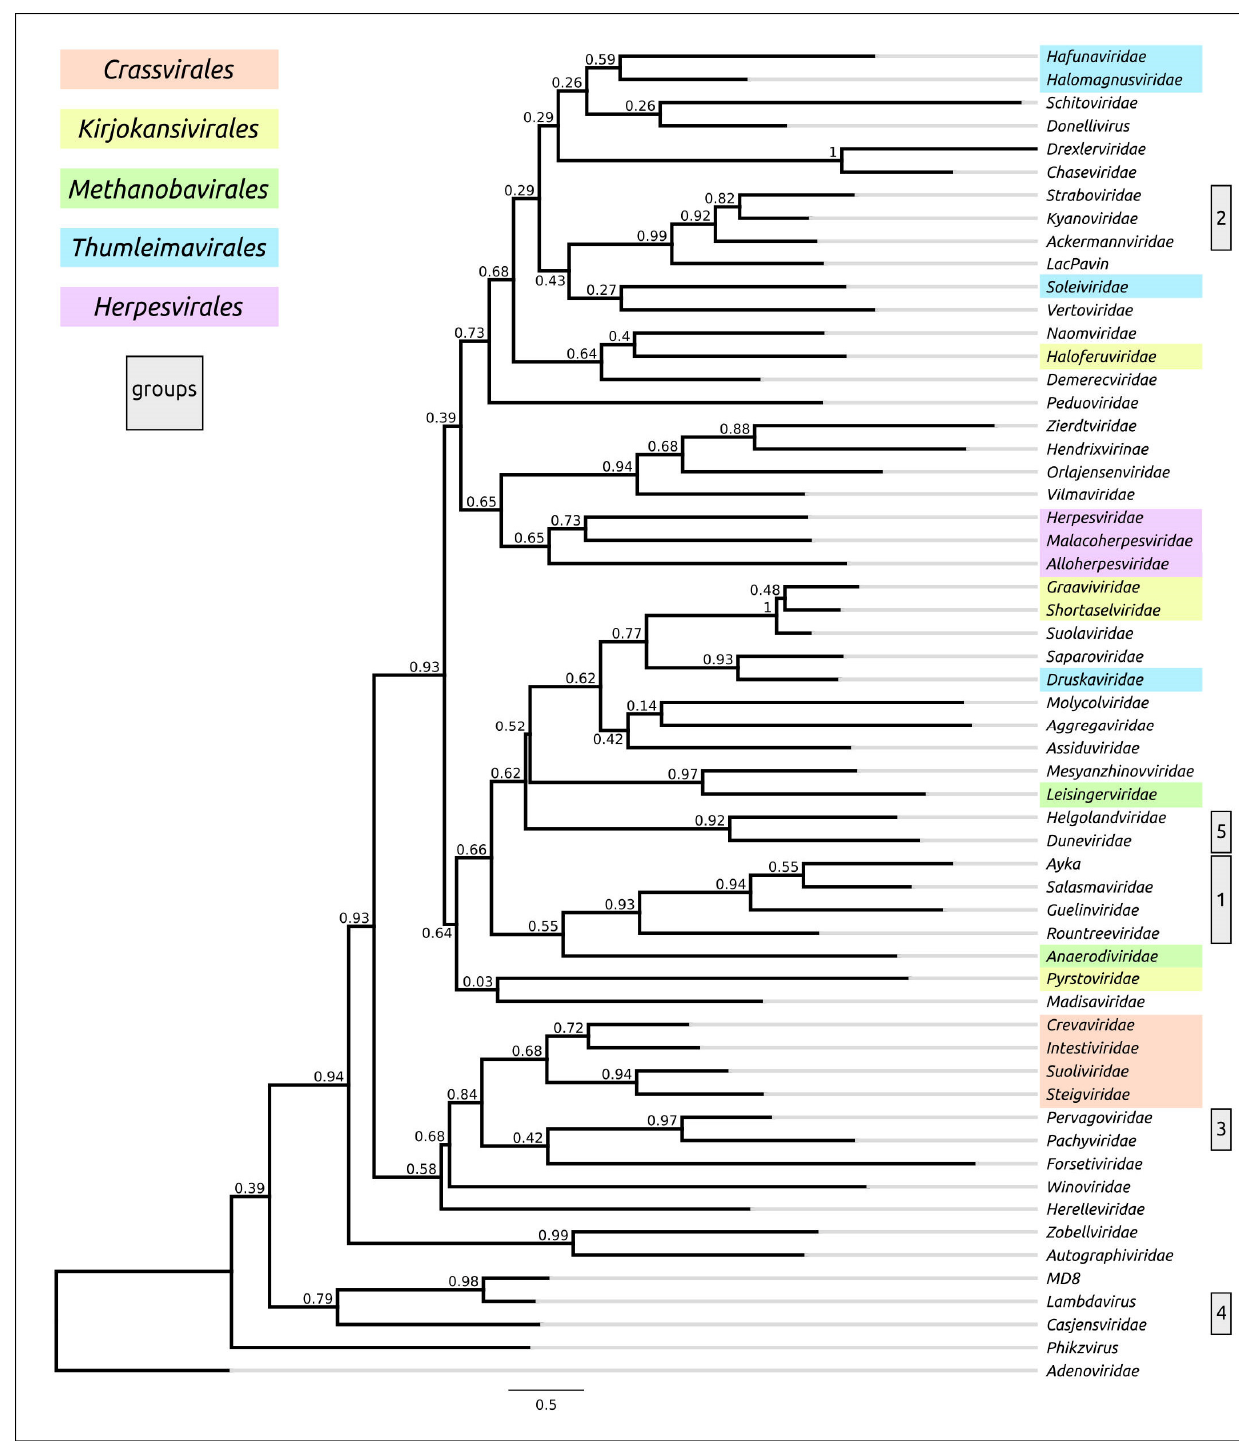
Figure 11. Best-scoring ML phylogenetic tree constructed with 57 amino acid sequences of ATPase subunits of Heunggongvirae terminases and an Adenoviridae terminase aligned with Clustal Omega. The numbers near the tree branches indicate the TBE support. The total number of bootstrap trees was 1000. The scale bar shows 0.5 estimated substitutions per site and the trees were rooted to Adenoviridae